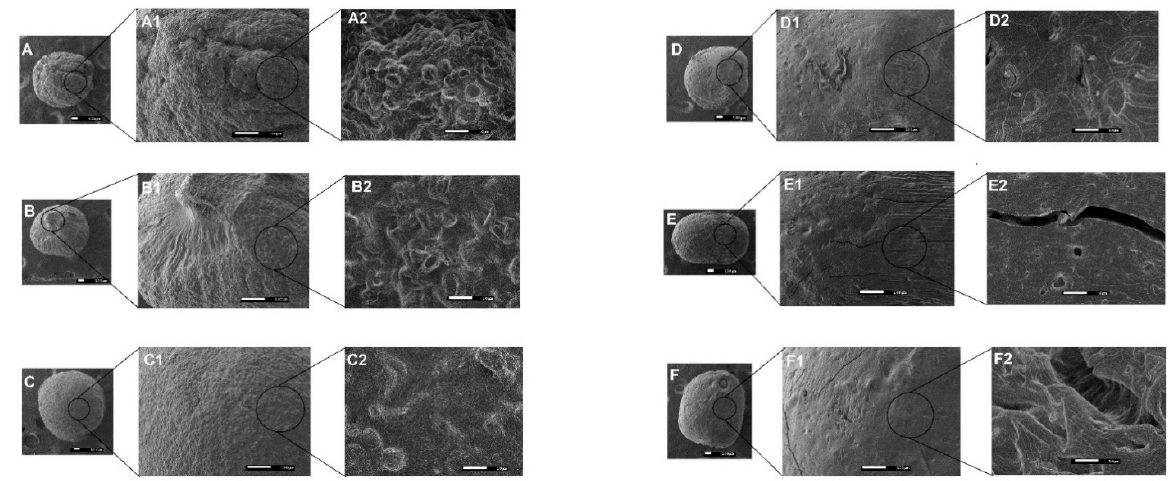
Figure 1. Photomicrographs of the polymeric microparticles (PMs) surface ( A : GRSCa at 40×, A1 : 150×, and A2 : 1500×; B : GRSAl at 40×, B1 : 150×, and B2 : 1500×; C : GRSCaAl at 40×, C1 : 150×, and C2 : 1500×; D : GPCa in 40×, D1 : 150×, and D2 : 1500×; E : GPAl in 40×, E1 : 150×, and E2 : 1500×; and F : GPCaAl in 40×, F1 : 150×, and F2 : 1500 ×).